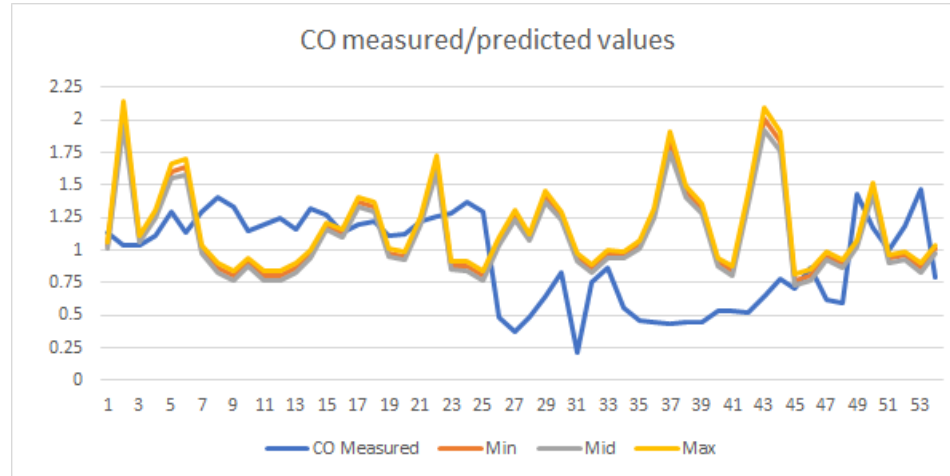
Figure 7. Diagram of comparatively presented real measurement data of CO and predicted values (range) of CO, based on linear correlation with NO values.